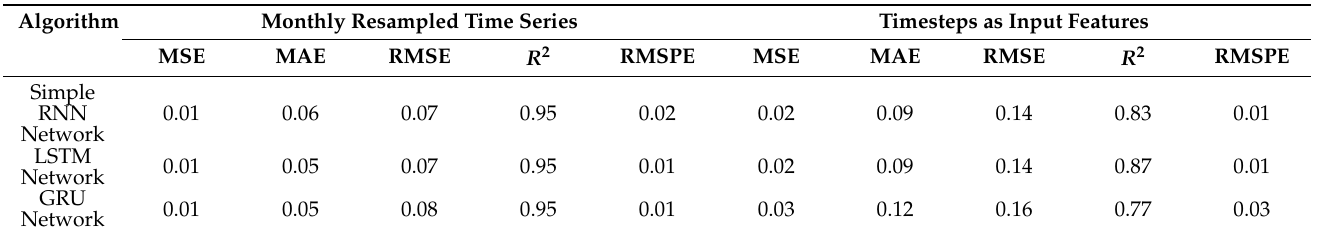
Table 11. Results when forecasting from all OCT data (including fundus image embeddings), from two previous visits.